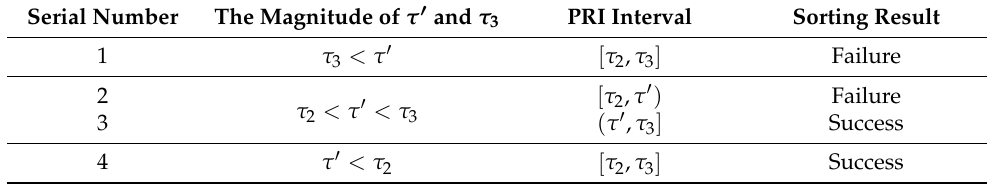
Table 1. Signal PRI value distribution and sorting